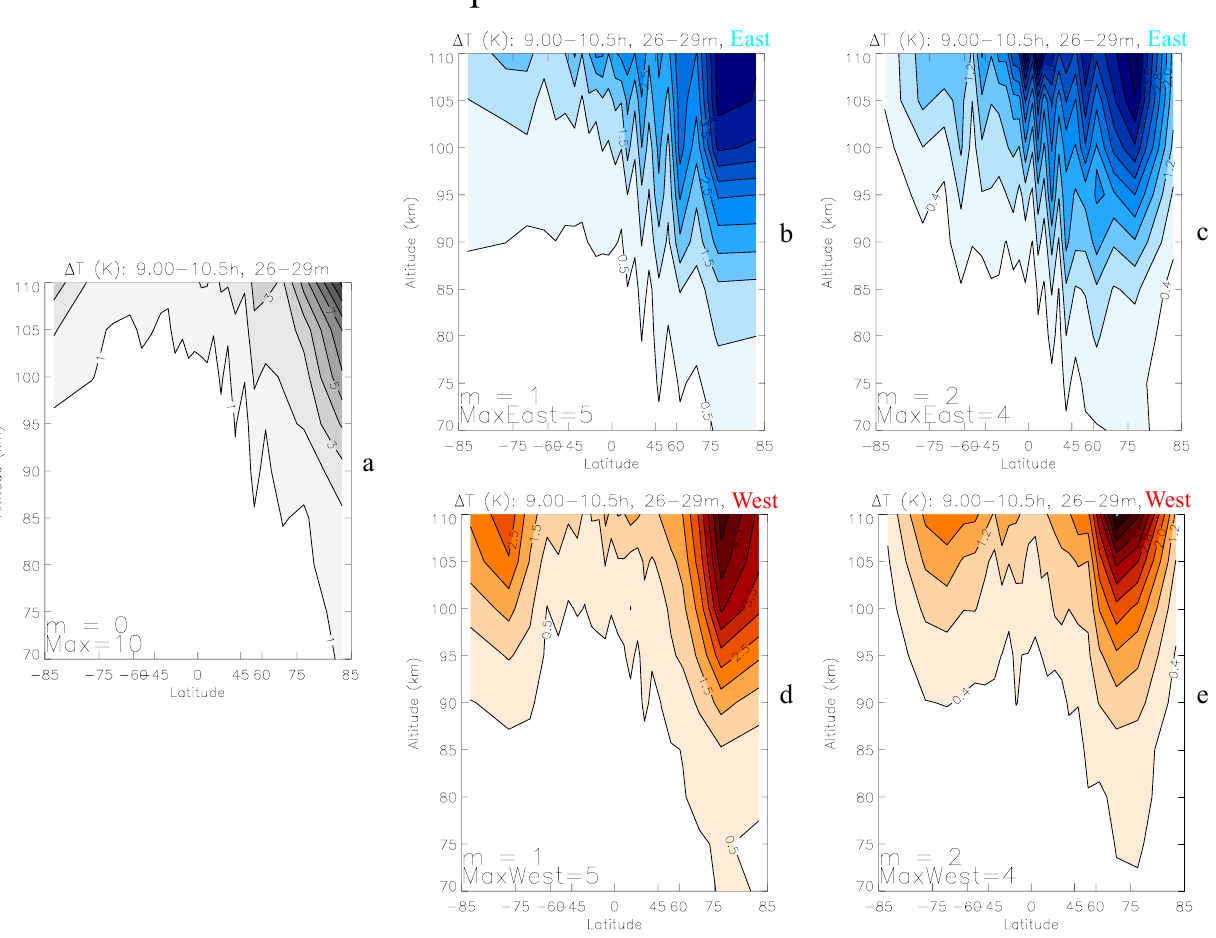
Fig. 4. Similar to Fig. 3 but for temperature